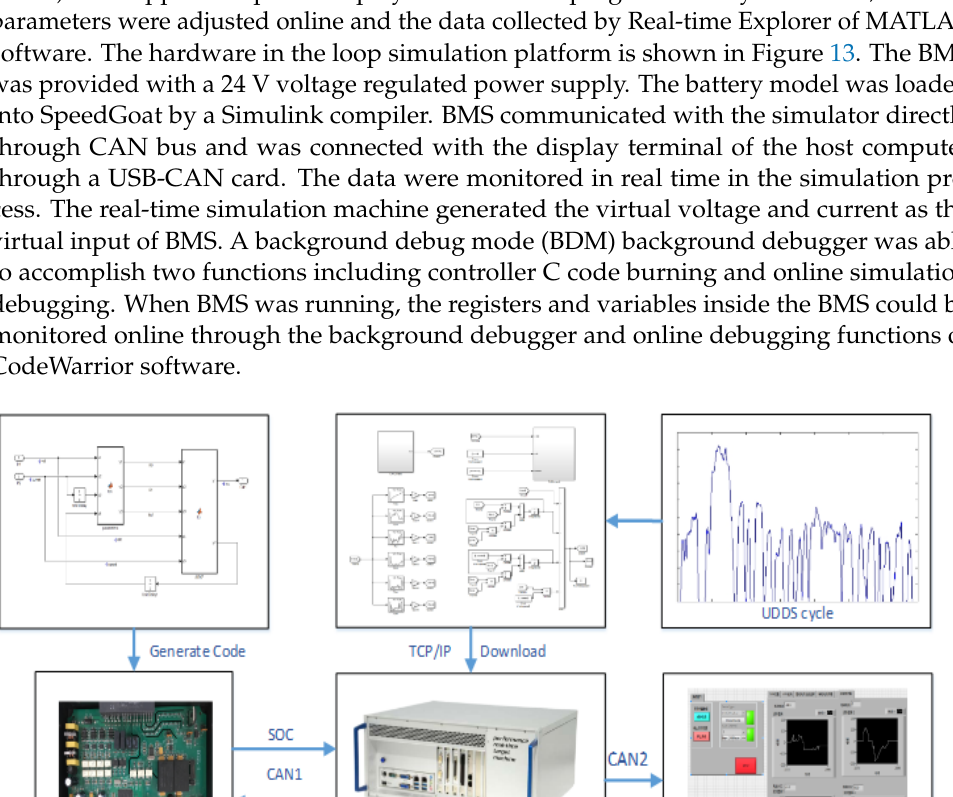
Figure 11. SOC estimation results in four states: ( a ) SOC estimation; ( b ) error of SOC estimation.